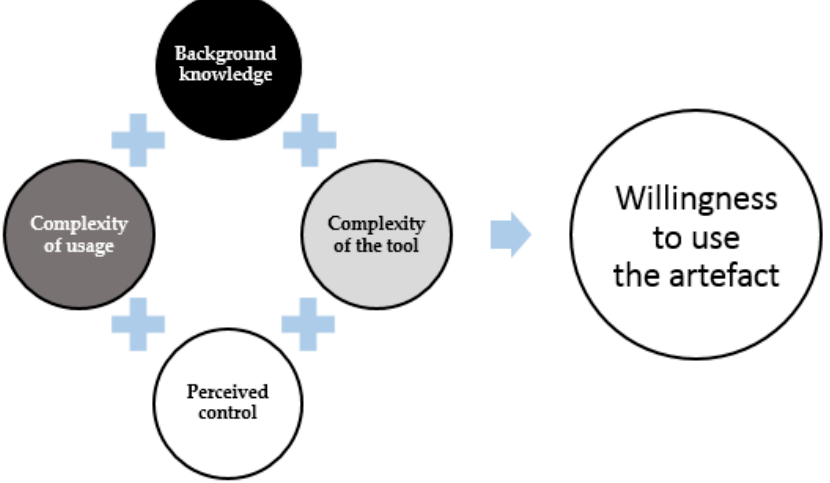
Figure 1. Low student willingness to use the artefact as influenced by the low perceived control.